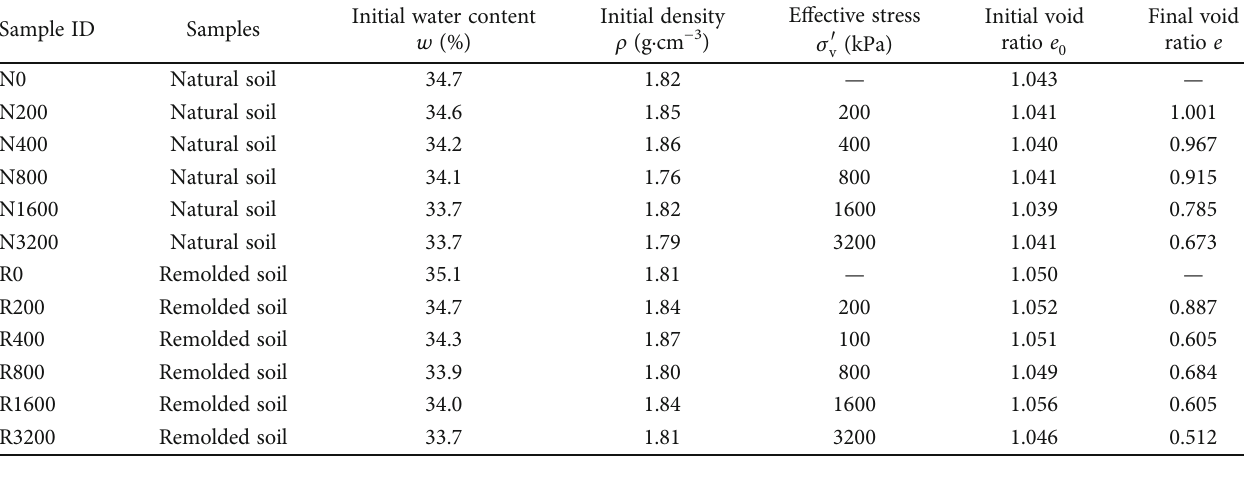
Table 2: Test schemes for GRS under one-dimensional compression.